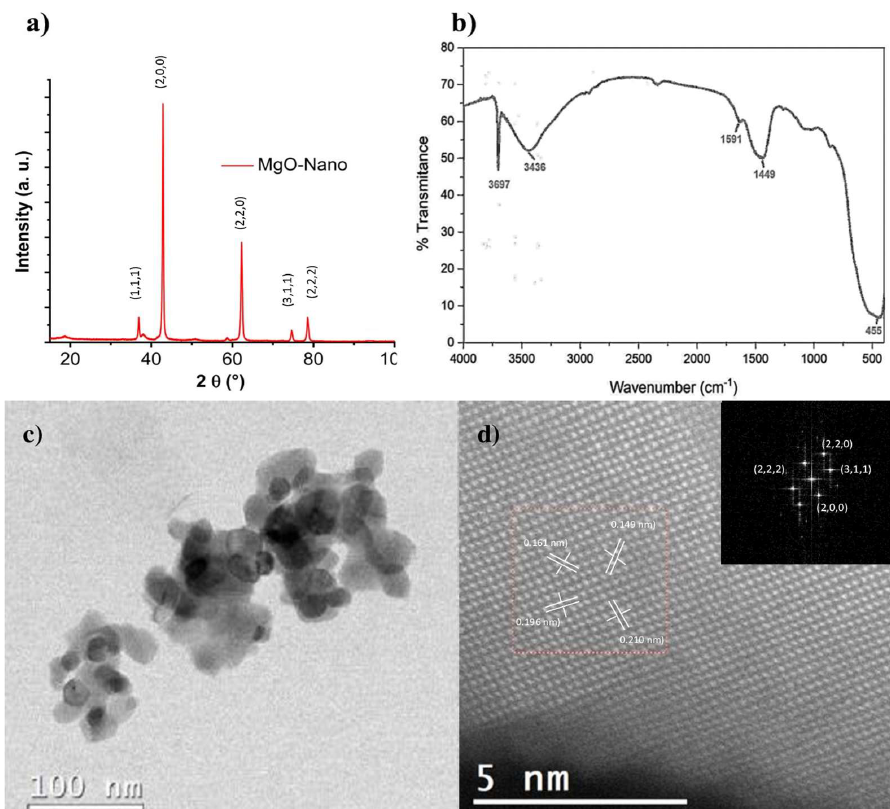
Figure 1. Characterization of MgO-NPs. ( a ) In X-ray diffraction, the peaks observed were indexed according to the JCPDS with the card number: 89-7746, and the corresponding crystal planes of MgO were indexed to (111), (200), (220), (311) and (222). ( b ) In FT-IR spectra, the signals at 3697 cm − 1 and 3436 cm − 1 are characteristic of the O–H stretching band. The peaks at 1449–1591 cm − 1 correspond to the bending vibration of the O–H; these strong bands appear due to the hygroscopic nature of MgO, whereas the strong peak around 455 cm − 1 is due to the stretching vibrations of the bond between Mg and O. ( c ) Transmission electron microscopy (high resolution) of MgO-NPs indicate the shapes to be polyhedric, with sizes smaller than or close to 100 nm. Likewise, the results of the analysis